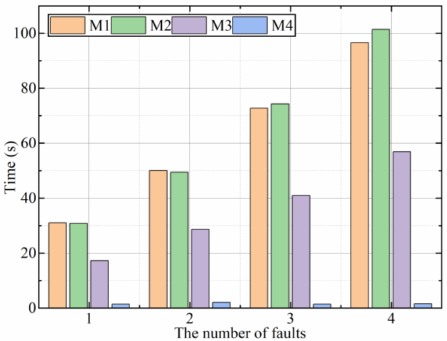
Figure 7. Efficiency